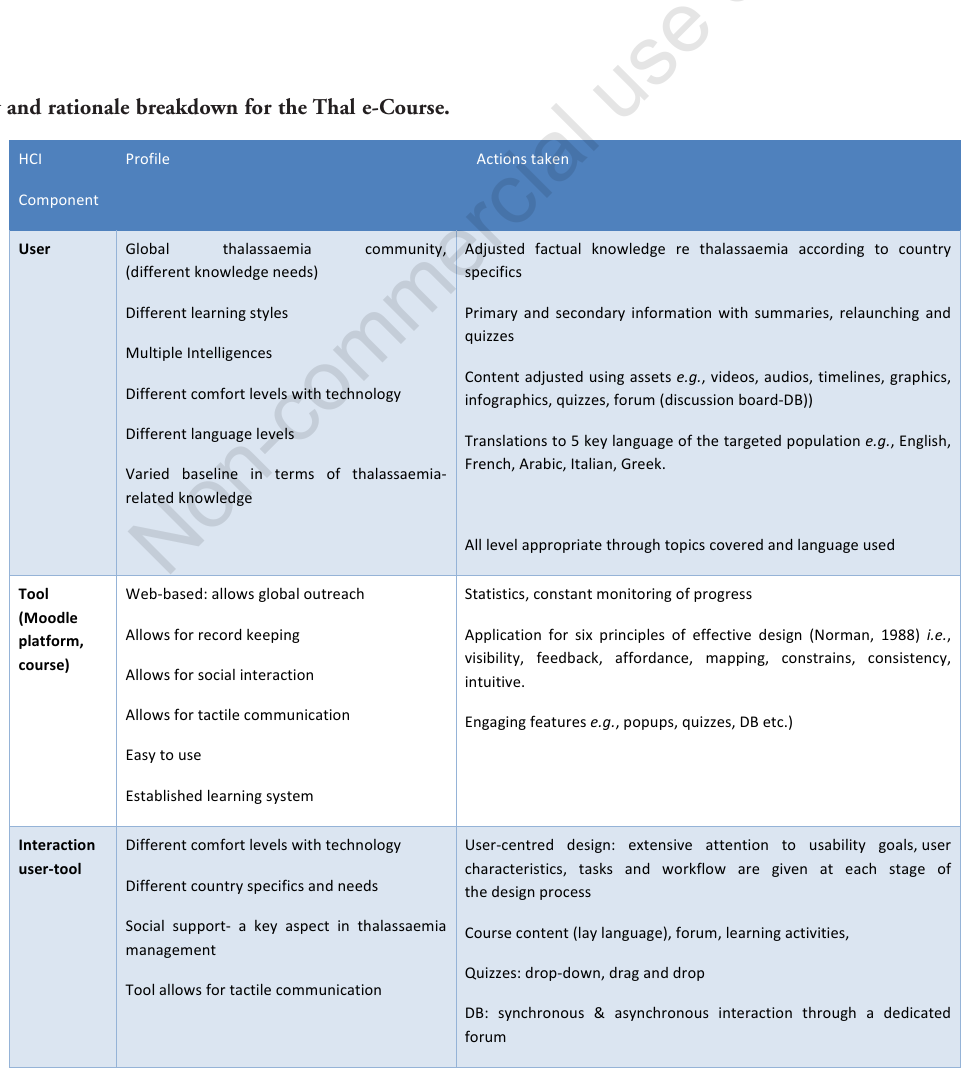
Table 1. Activity and rationale breakdown for the Thal e-Course.